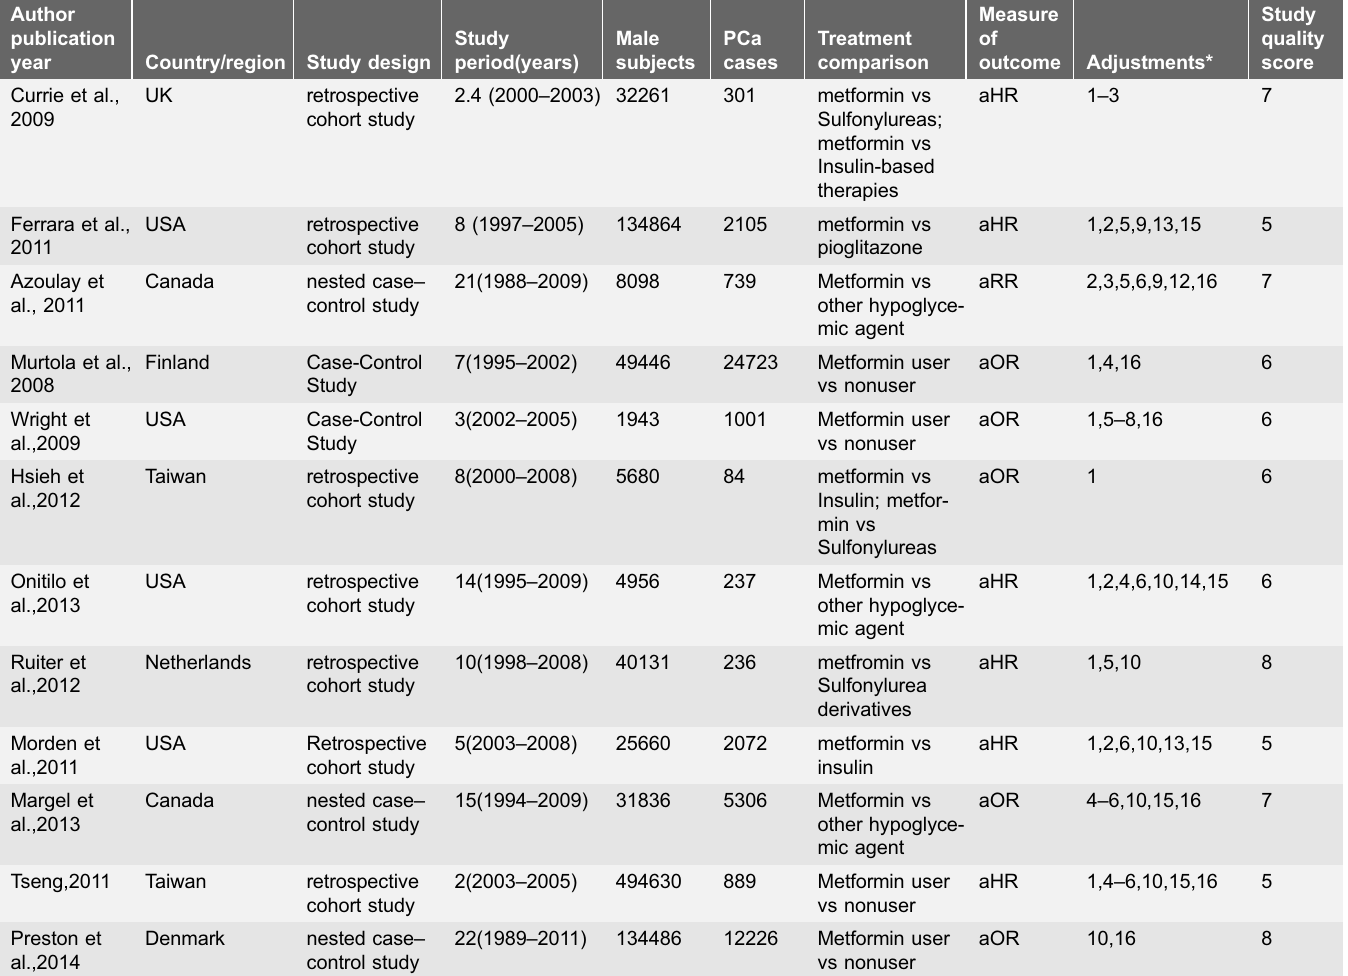
Table 1. Characteristics of the included studies for the risk of prostate cancer